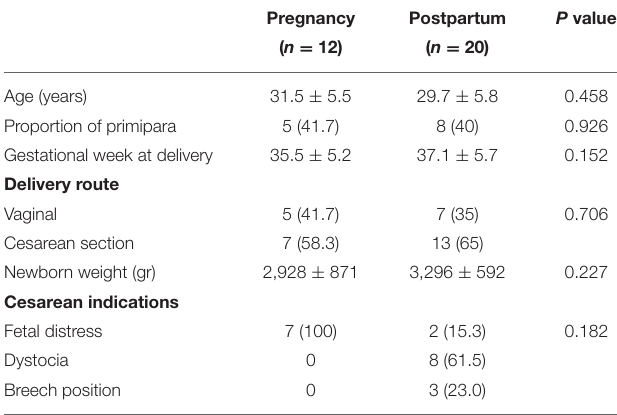
TABLE 2 | Characteristics of women who underwent appendectomy during pregnancy and